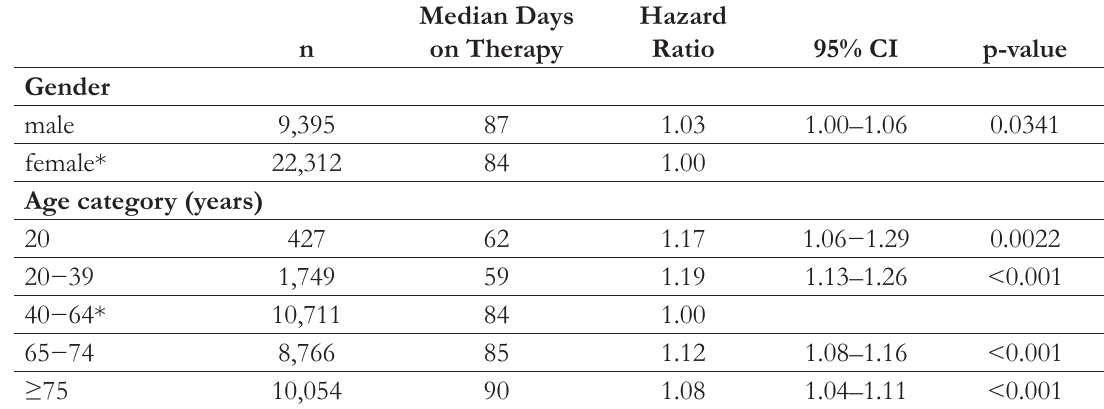
Table 2. Median Days on Therapy and Hazard Ratios for Risk of Discontinuation, According to Gender